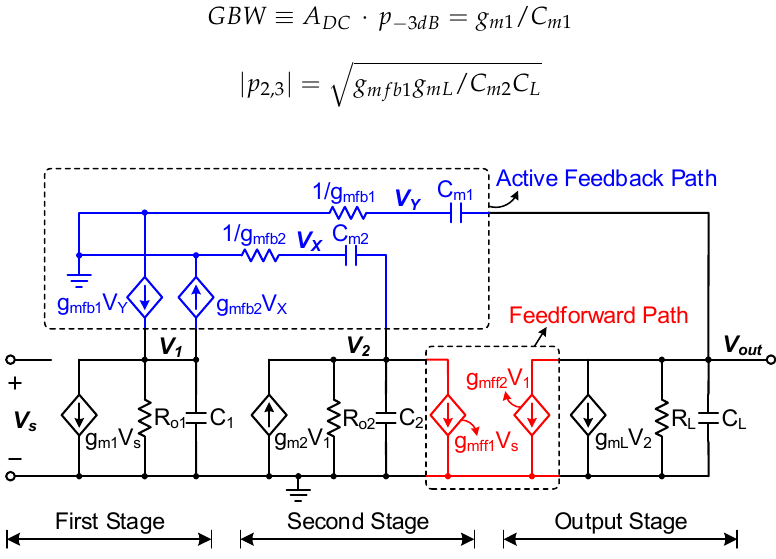
Figure 5. Small-signal equivalent circuit of the proposed AFCFC.